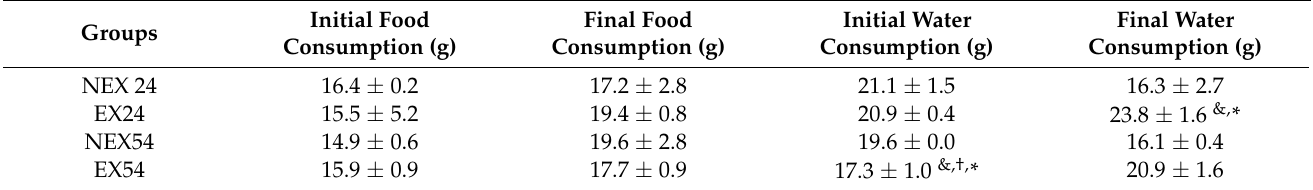
Table 2. Mean food and water consumption (g) (mean ± SD) at the beginning and at the end of the experimental